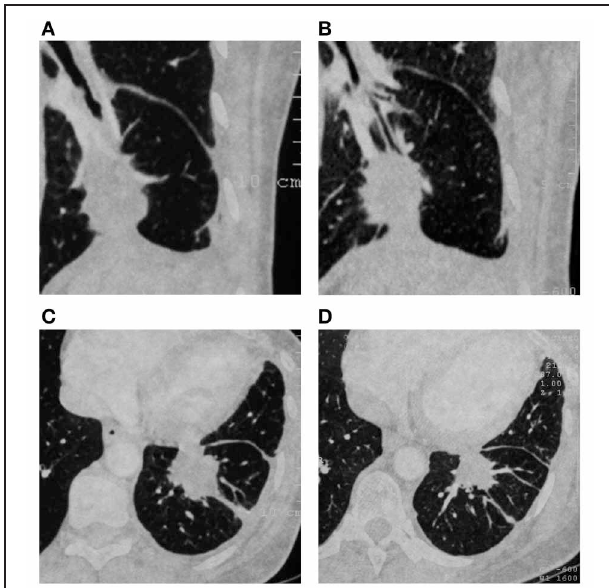
FIGURE 1 | Stable disease after maintenance treatment with Racotumomab and pemetrexed. (A,C) Computed tomography in March 2010 before treatment. (B,D) Computed tomography in February 2012, last